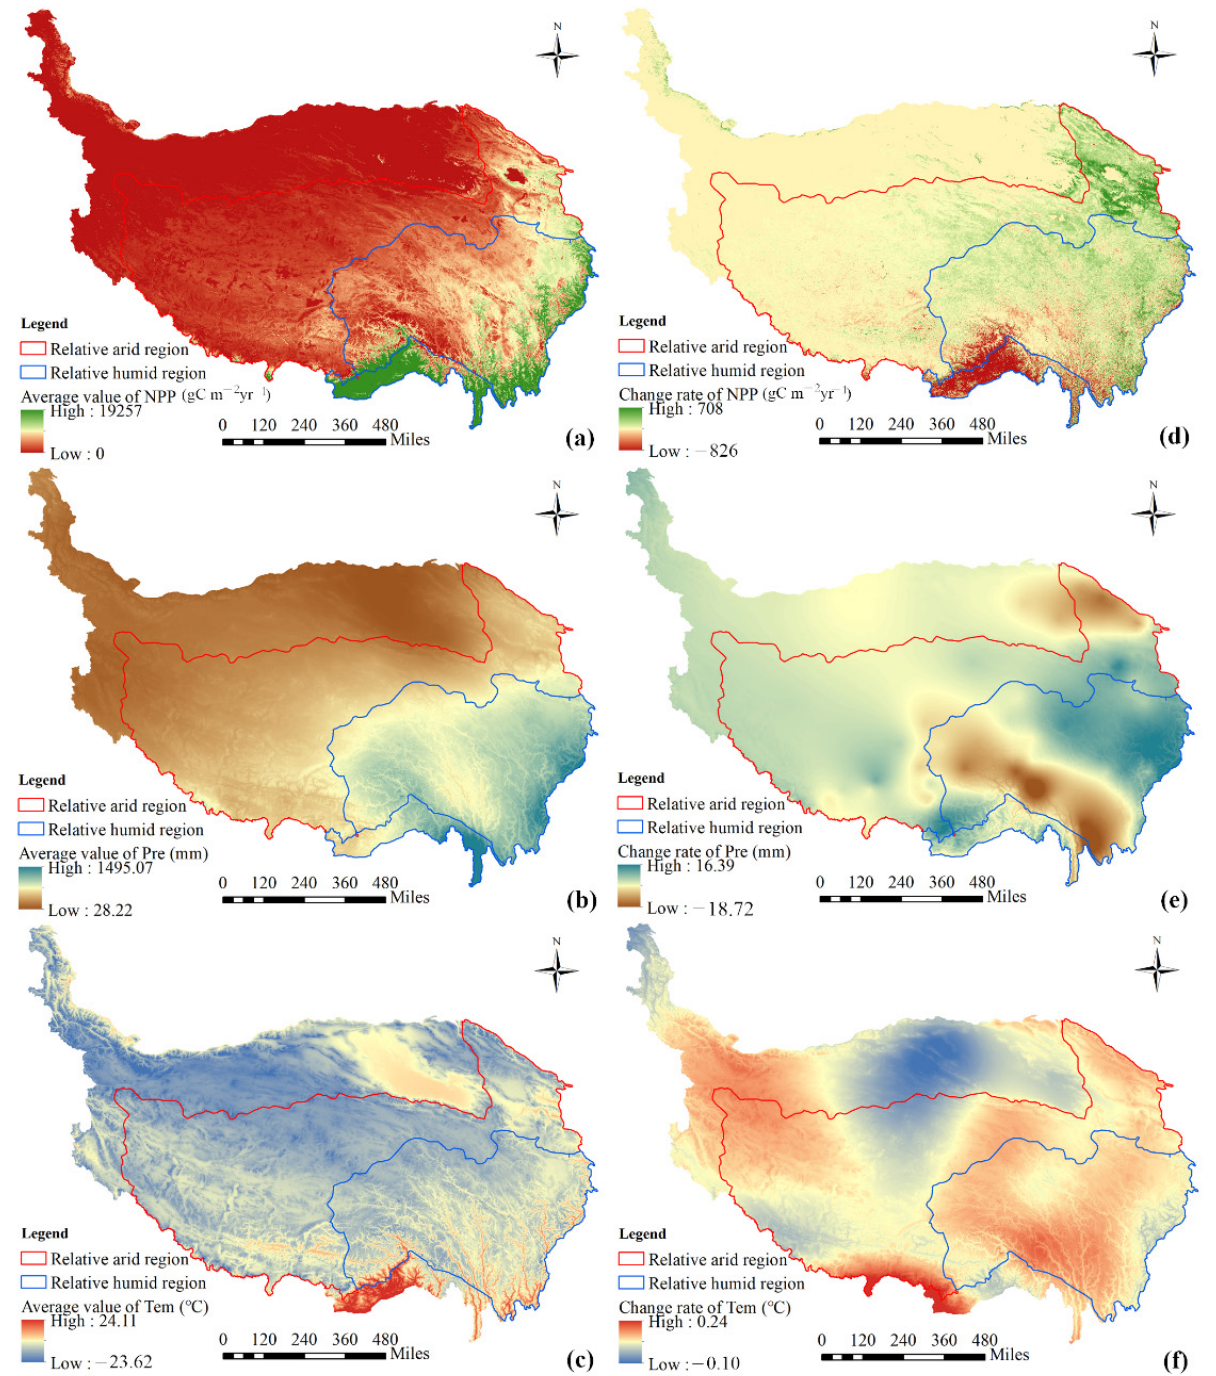
Figure 3. The average value of the NPP ( a ), precipitation (Pre, ( b )), and temperature (Tem, ( c )) from 2001 to 2019 in space and the change rate in the NPP ( d ), precipitation ( e ), and temperature ( f ) from 2001 to 2019 in space.